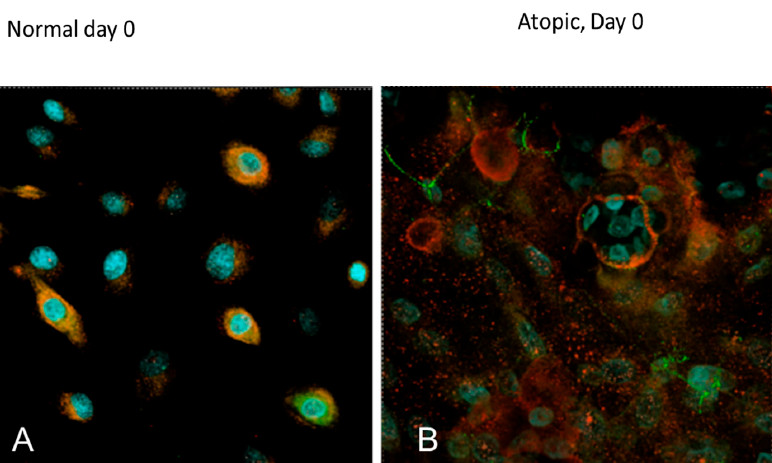
Figure 13. Confocal microscopy images of normal and atopic keratinocytes at the first day of con- fluence (D0). Confocal microscopy was performed on Nikon A1RMPsi-STORM4.0 on the 60 X water objective. On the left ( A ), keratinocytes harvested from a normal dog while on the right ( B ), keratino- cytes harvested from an atopic dog. Filaggrin 2 is stained in red and occludin is in green. Filaggrin 2 shows primarily in the cytoplasm in these images. Light blue was DAPI, a fluorescent DNA stain, to locate the nucleus of the cells.